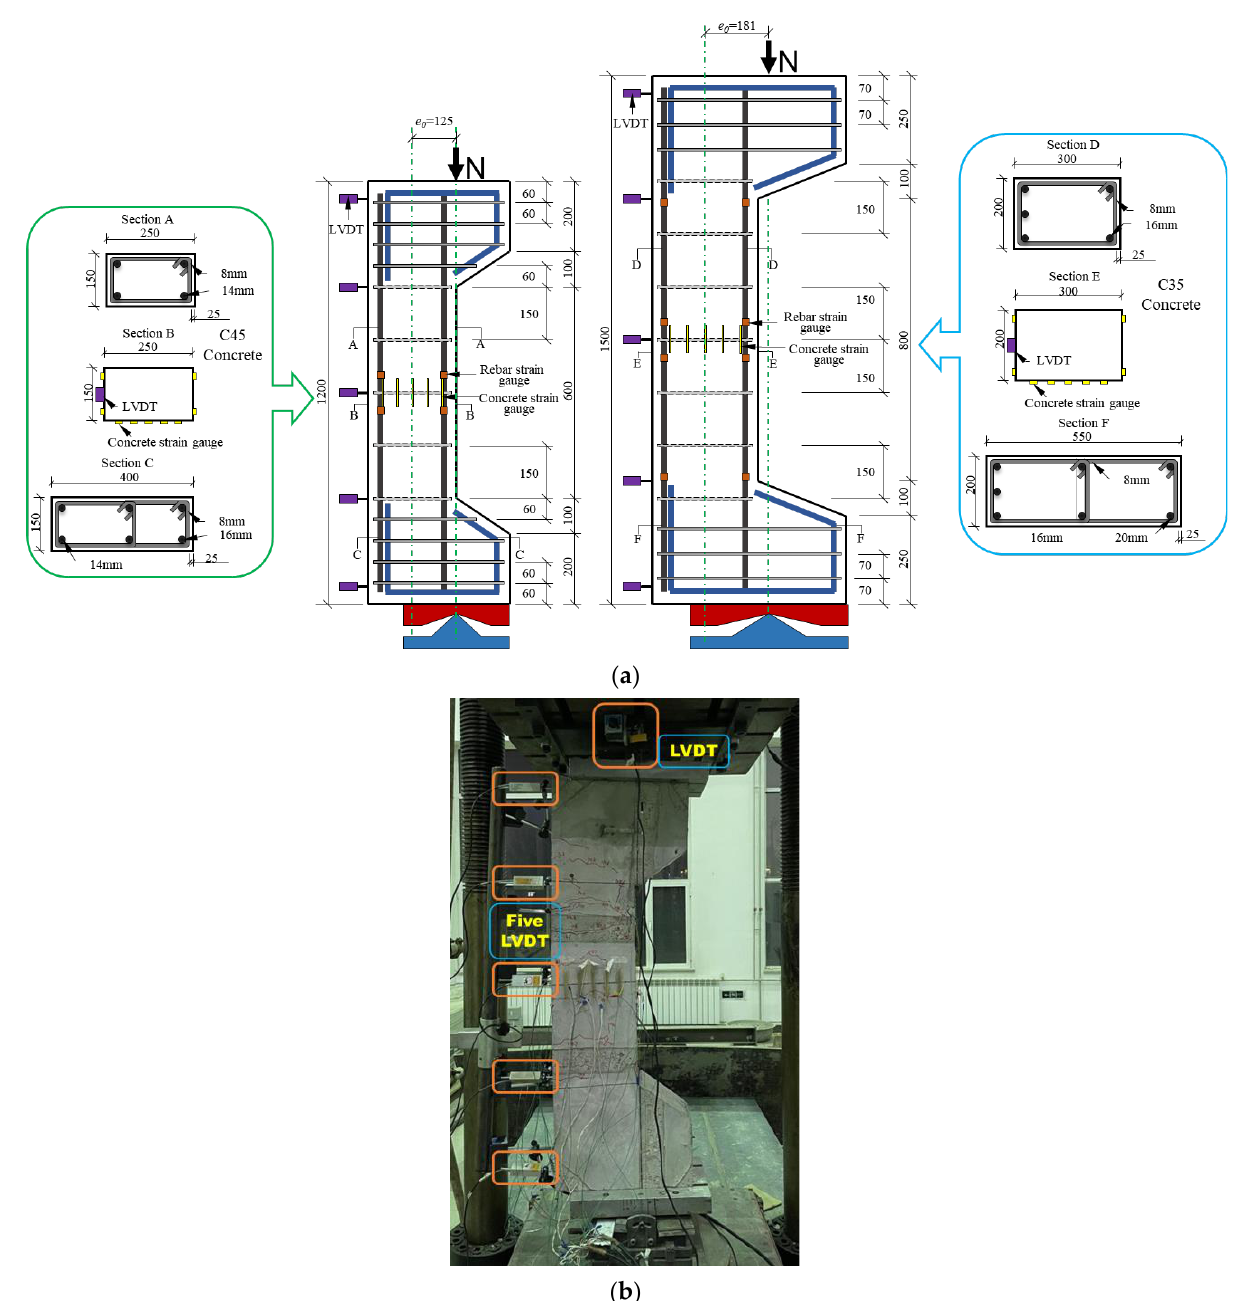
Figure 7. Compression test on RC columns under large eccentric loading: ( a ) geometry and reinforcement details of RC columns (unit: mm); ( b ) test setup.